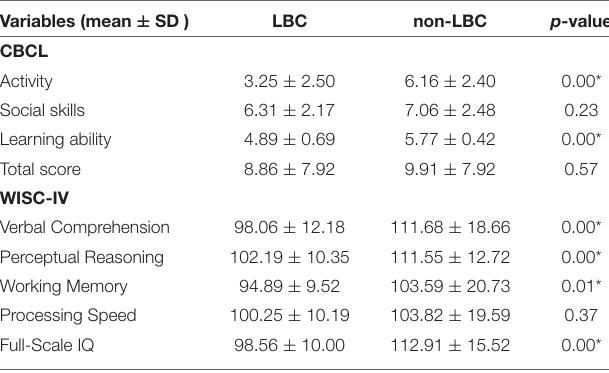
TABLE 2 | Behavioral and cognitive assessment of LBC and HC.